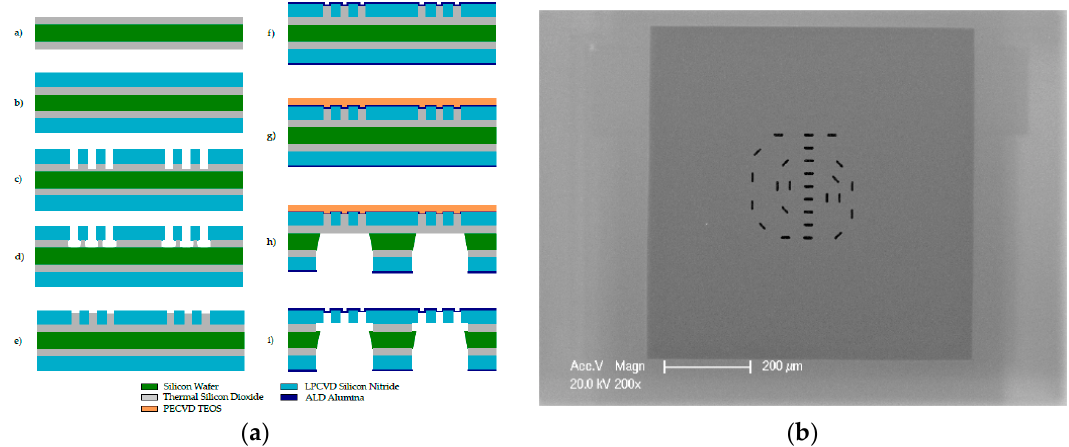
Figure 2. ( a ) Process flow for Al 2 O 3 ETWs. ( b ) a resulting SEM image of the device which includes the ETWs suspended in a SiN supporting membrane